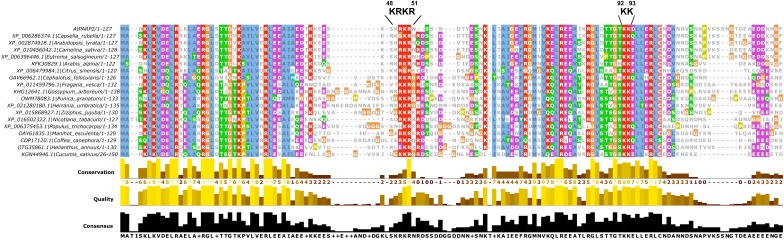
Multiple sequence alignment showing the partial conservation of the KRKR motif (PARP2 amino acids 48–51) in PARP2 homologs from different plant species. Only the SAP domains are shown. The sequence alignment was generated with Clustal Omega (Sievers and Higgins, 2014).